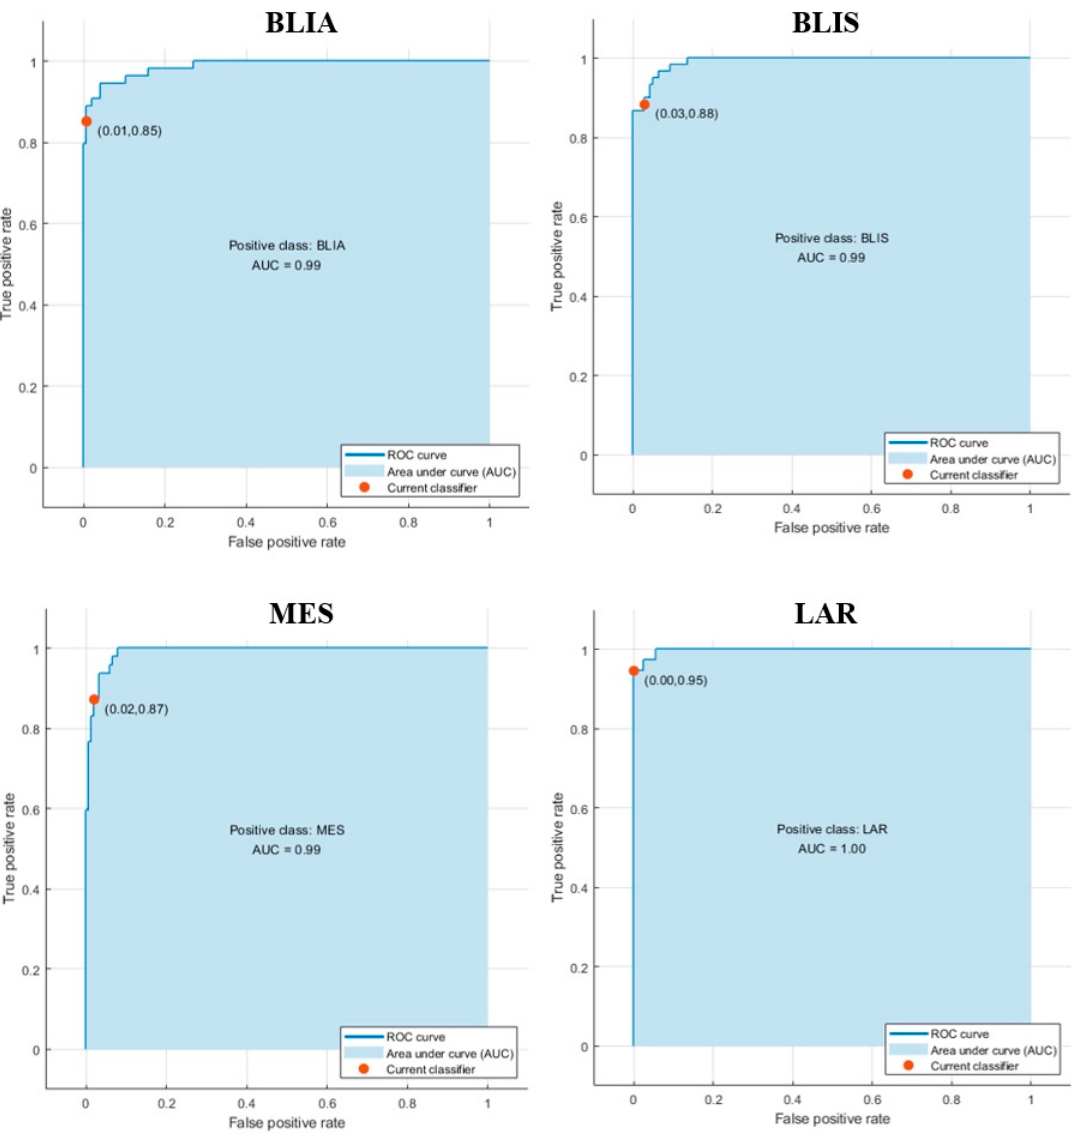
Figure 4. Performance evaluation of the best classification models using ROC curves and AUC values for BLIA, BLIS, MES, and LAR.